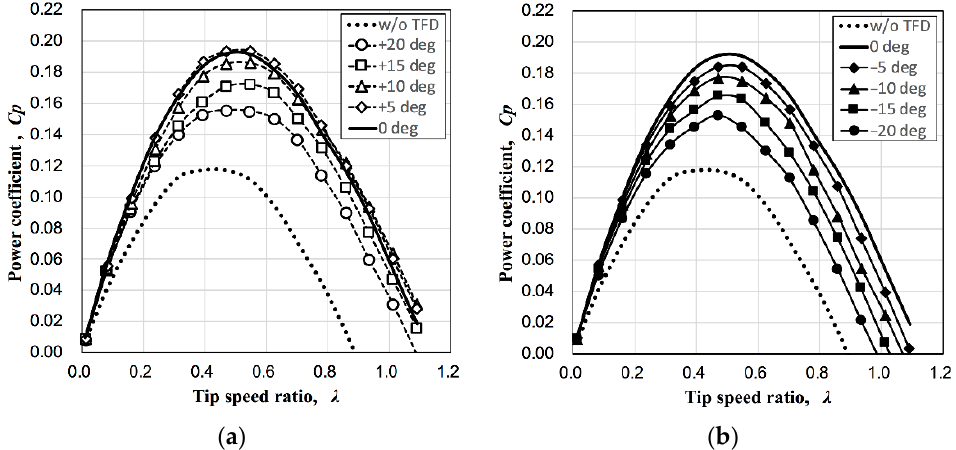
Figure 11. Performance curves of cross-flow wind turbine with three flow deflectors compared with the case with no flow deflector (w/o TFD), ( a ) inclination angles 0° to +20°; ( b ) inclination angles −20° to 0°.